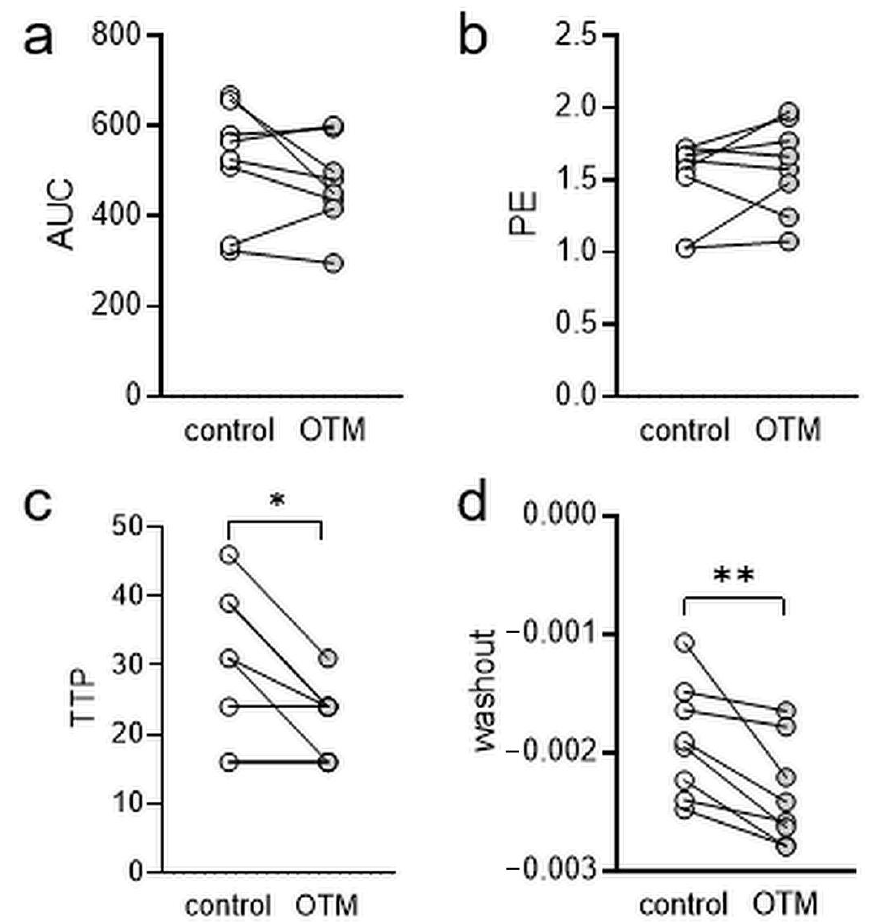
Figure 2. Determination of area under the curve (AUC; ( a )), peak enhancement (PE; ( b )), time to peak (TTP; ( c )), and washout rate ( d ) of dynamic-contrast-enhanced MRI ( n = 8). OTM = orthodontic tooth movement. * p < 0.05. ** p < 0.01.